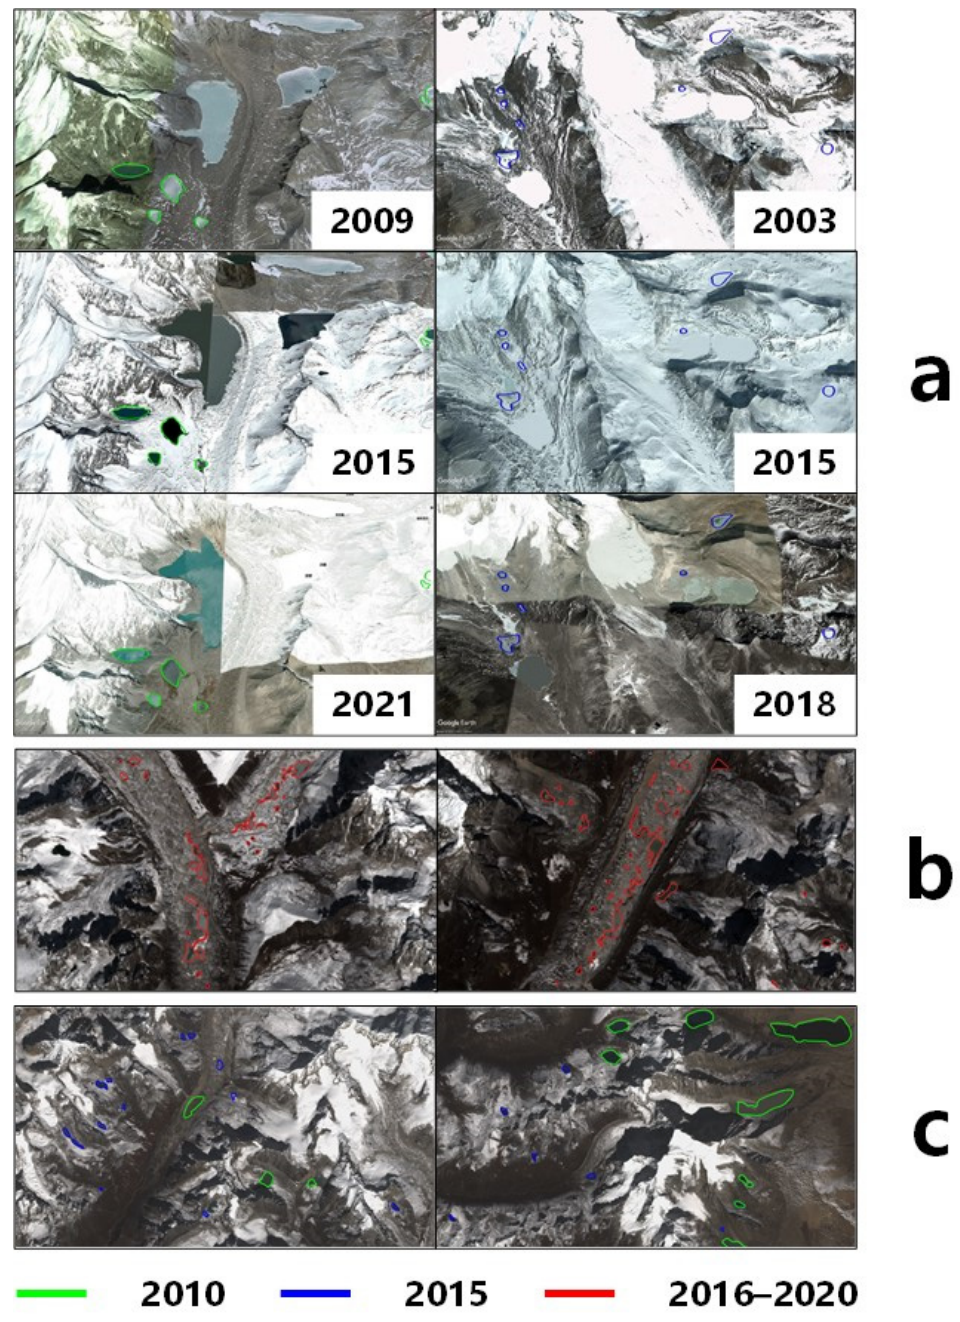
Figure 10. Comparison of lake inventories from different years: ( a ) We found some glacial lakes that were not mapped in the 2010 and 2015 inventories, according to historical images from different periods obtained from Google Earth. ( b ) Most glacial thaw lakes were not mapped in the 2010 and 2015 inventories. ( c ) Lack of consistency between the 2010 and 2015 inventories. Our inventory captured nearly all glacial lakes identified by the two reference datasets, suggesting low commission errors with our inventory compared to the two datasets. However, only 120 glacial lakes were reported by both datasets (Figure 10c). The lack of consistency between them is likely due to differences in methods and guidelines adopted by the two datasets. The comparison also signals the urgency for mapping glacial lakes at finer scales with higher-resolution satellite data to fill the gaps in our understanding of glacial lakes, especially regarding those small in size but high in